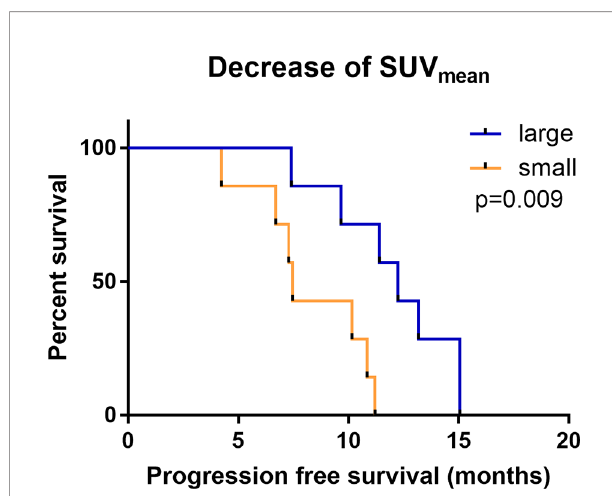
FIGURE 2 | Kaplan-Meier analysis of PFS comparing groups with a large (red) and small (blue) change in the SUV mean .